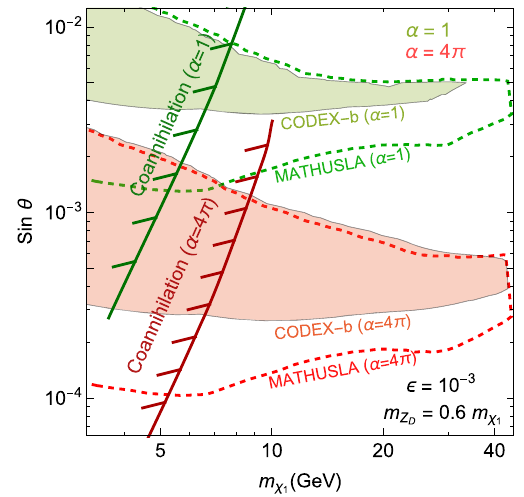
Fig. 19 Projected sensitivity to the coscattering dark matter bench- mark for α D = 1 (green) and α D = 4 π (red). The shaded region represents the reach for CODEX-b with 300 fb − 1 . The dashed line is the reach for MATHUSLA in the 200 m × 200 m configuration with 3 ab − 1 . To the left of the dark hatched line, the coannihilation process of χ ¯ χ → Z D Z D remains active long enough to deplete the relic abun- 2 1 dance of χ 1 below the observed amount so that the model is inconsistent to the left of these